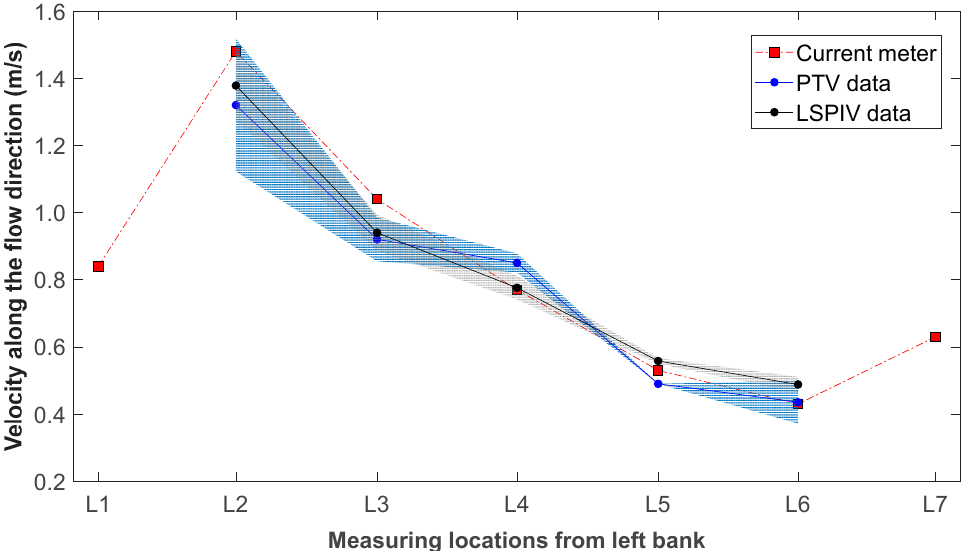
Figure 9. Comparison between surface velocity estimations computed with PTV and LSPIV for experiments conducted in the Bradano River. Shaded regions indicate standard deviations between frame sequences. Values recorded with the current meter are indicated by red squares.